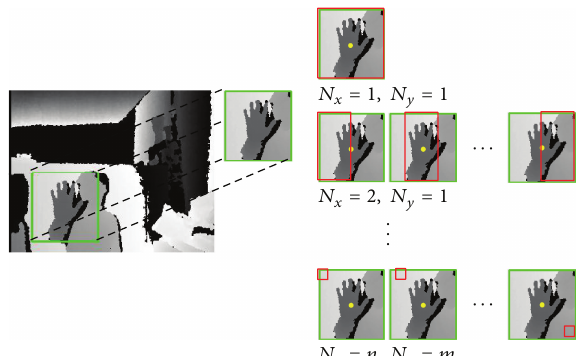
Figure 3: Example of feature